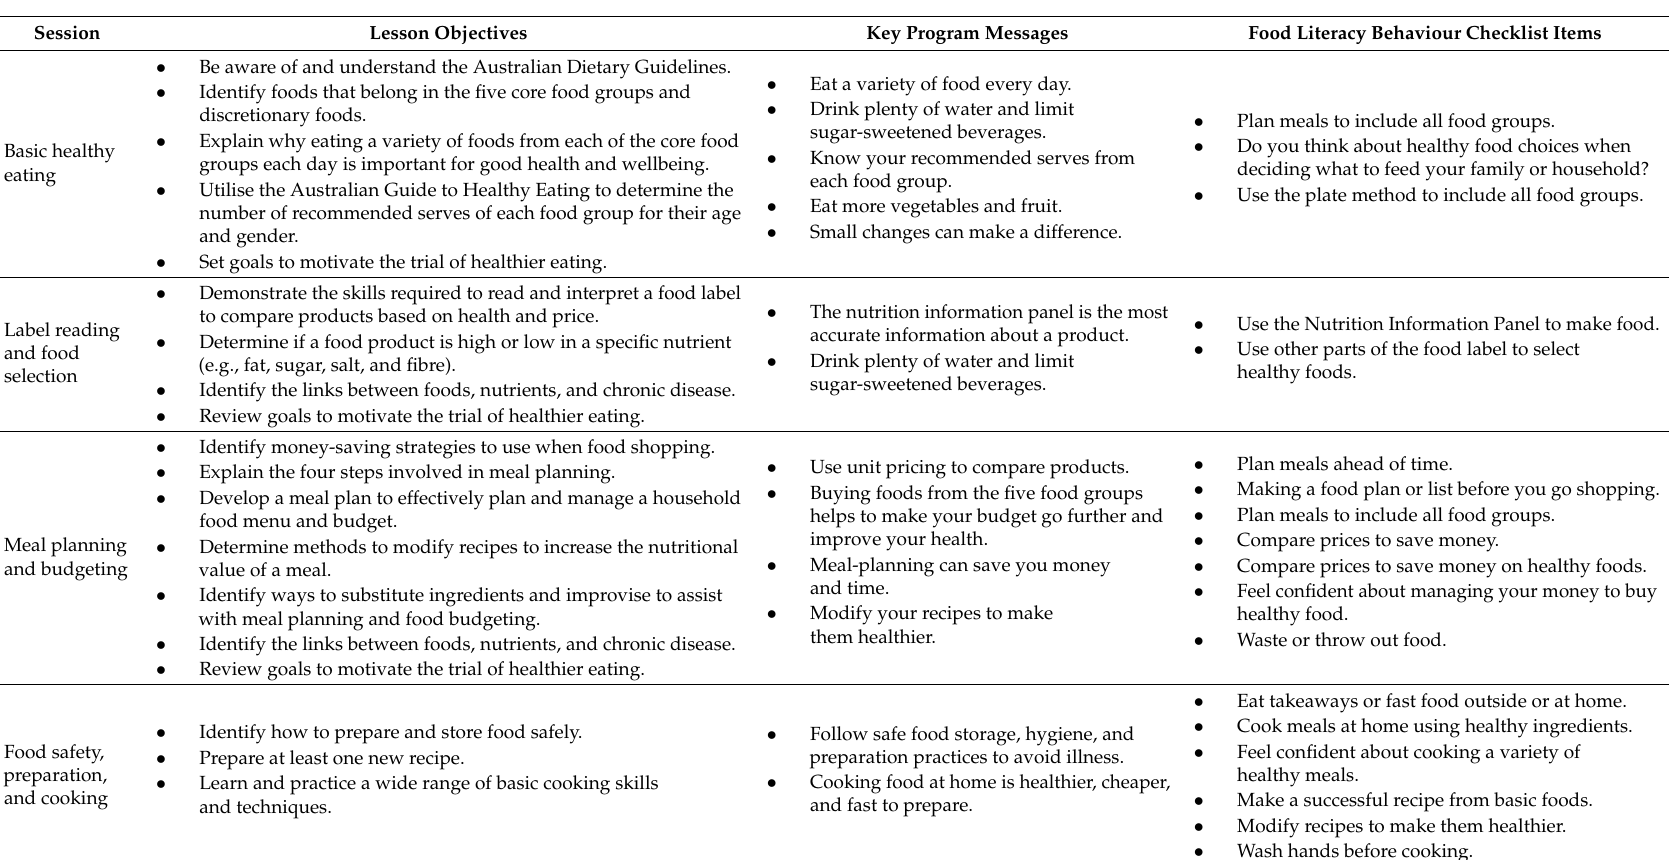
Table 1. Original item selection aligned with session